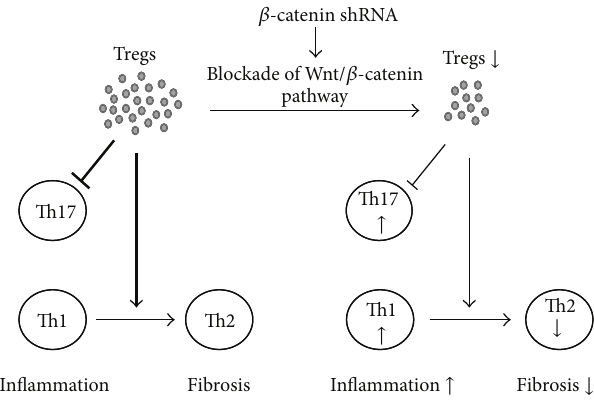
Figure 8: A schematic representation for the modulation of Th immune responses by blocking Wnt/ 𝛽 -catenin pathway in